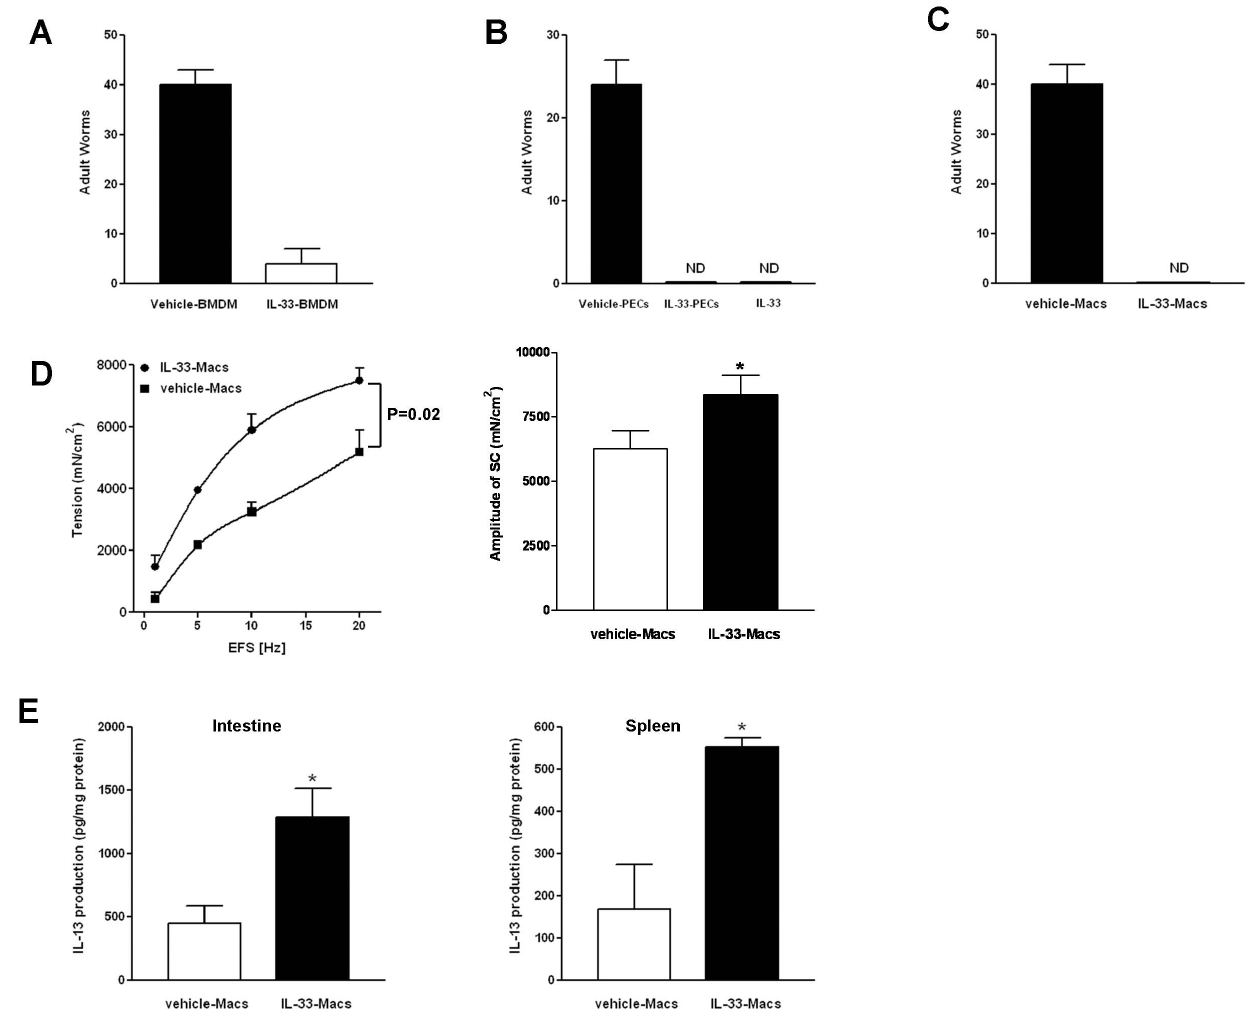
Figure 6. Adoptive transfer of IL-33-activated macrophages promoted protective immunity against H.bakeri(Hb) infection. A–C, Numbers of adult worms in the lumen of small intestine in mice receiving BMDM (A), PECs (B), or CD11b MicroBead-enriched PECs (C). D, E, Enhanced type 2 immunity in mice that received IL-33-activated CD11b MicroBead-enriched PECs (IL-33-Macs). Intestinal smooth muscle function (D) and in situ IL-13 production in the small intestine and spleen (E) were shown. Data shown in bar and line graphs are the mean 6 s.e.m, and are representative of two independent experiments (n=3–6 mice per group, *p , 0.05 vs respective vehicle-Macs, t test; p=0.02 was generated from two-way ANOVA with repeated measures between the two curves). ND, not detected.